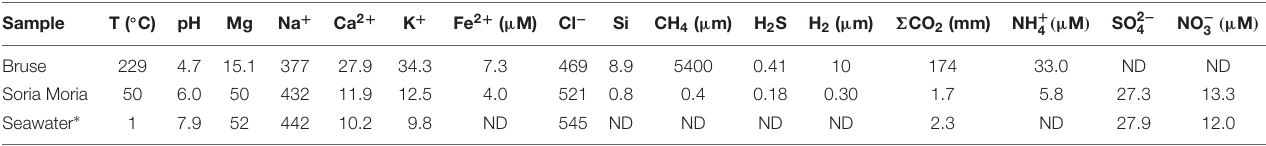
TABLE 3 | Chemical composition of vent fluids and seawater used in this study. Sample